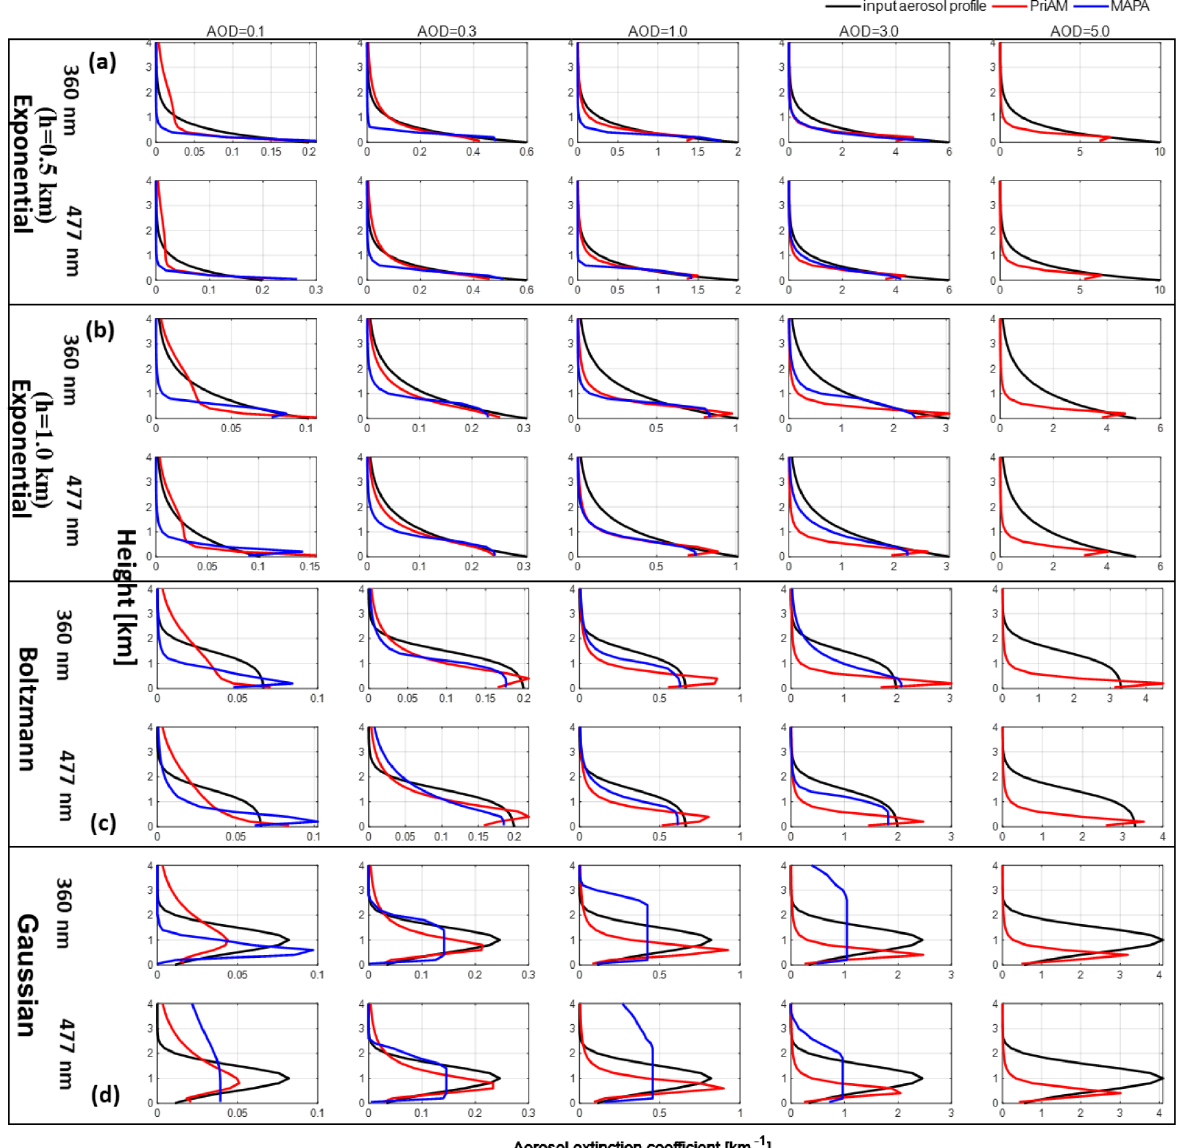
Figure 2. Comparison of the aerosol profiles retrieved by PriAM and MAPA for 360nm (first line) and 477nm (second line) and the corresponding input aerosol profiles for (a) exponential shape with h = 0.5km, (b) exponential shape with h = 1.0km, (c) Boltzmann shape, and (d) Gaussian shape. The red and blue curves indicate the results from PriAM and MAPA, respectively. The corresponding relative deviations and absolute deviations are shown in Figs. S8 and S9, respectively. Note that MAPA by default flags cases where the retrieved AOD exceeds 3; thus the high aerosol scenarios are missing for